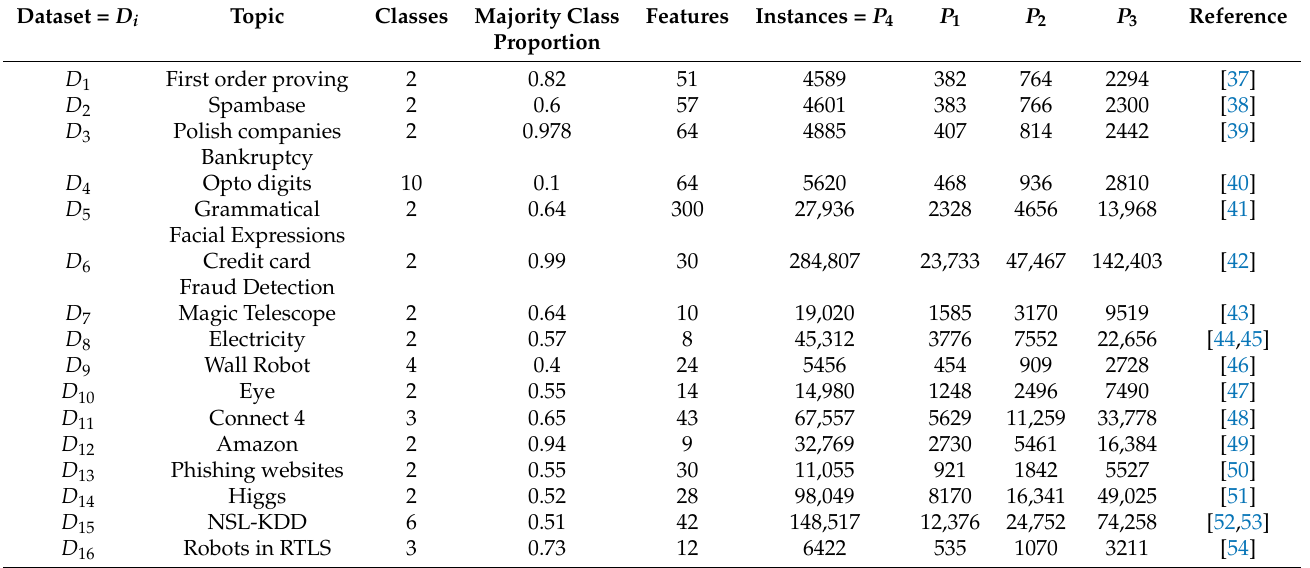
Table 5. Descriptions of